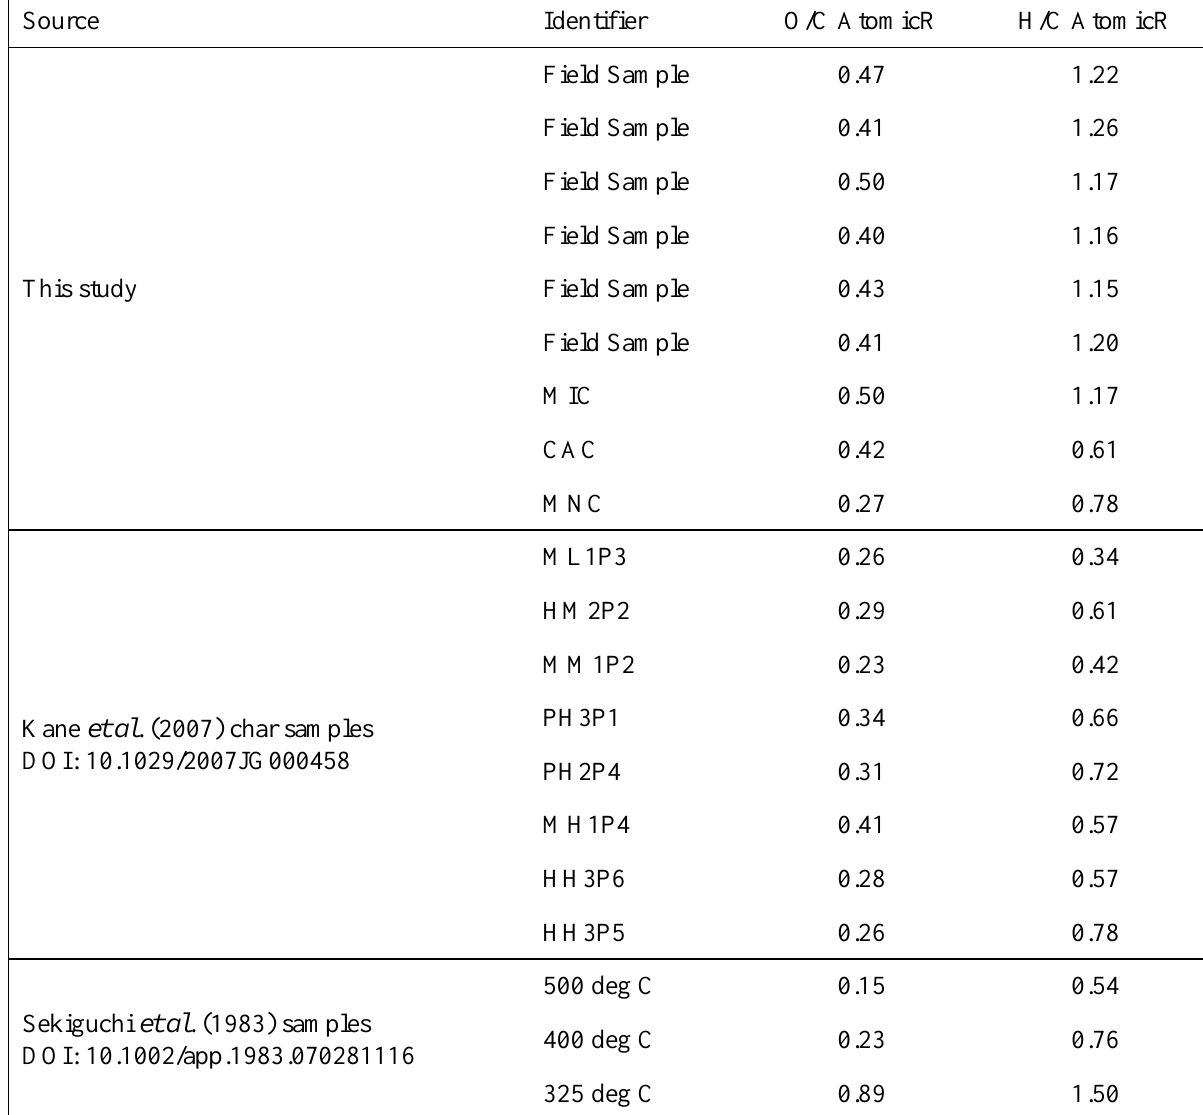
Table A1. Atomic ratios for the van Krevelen diagram presented in Figure